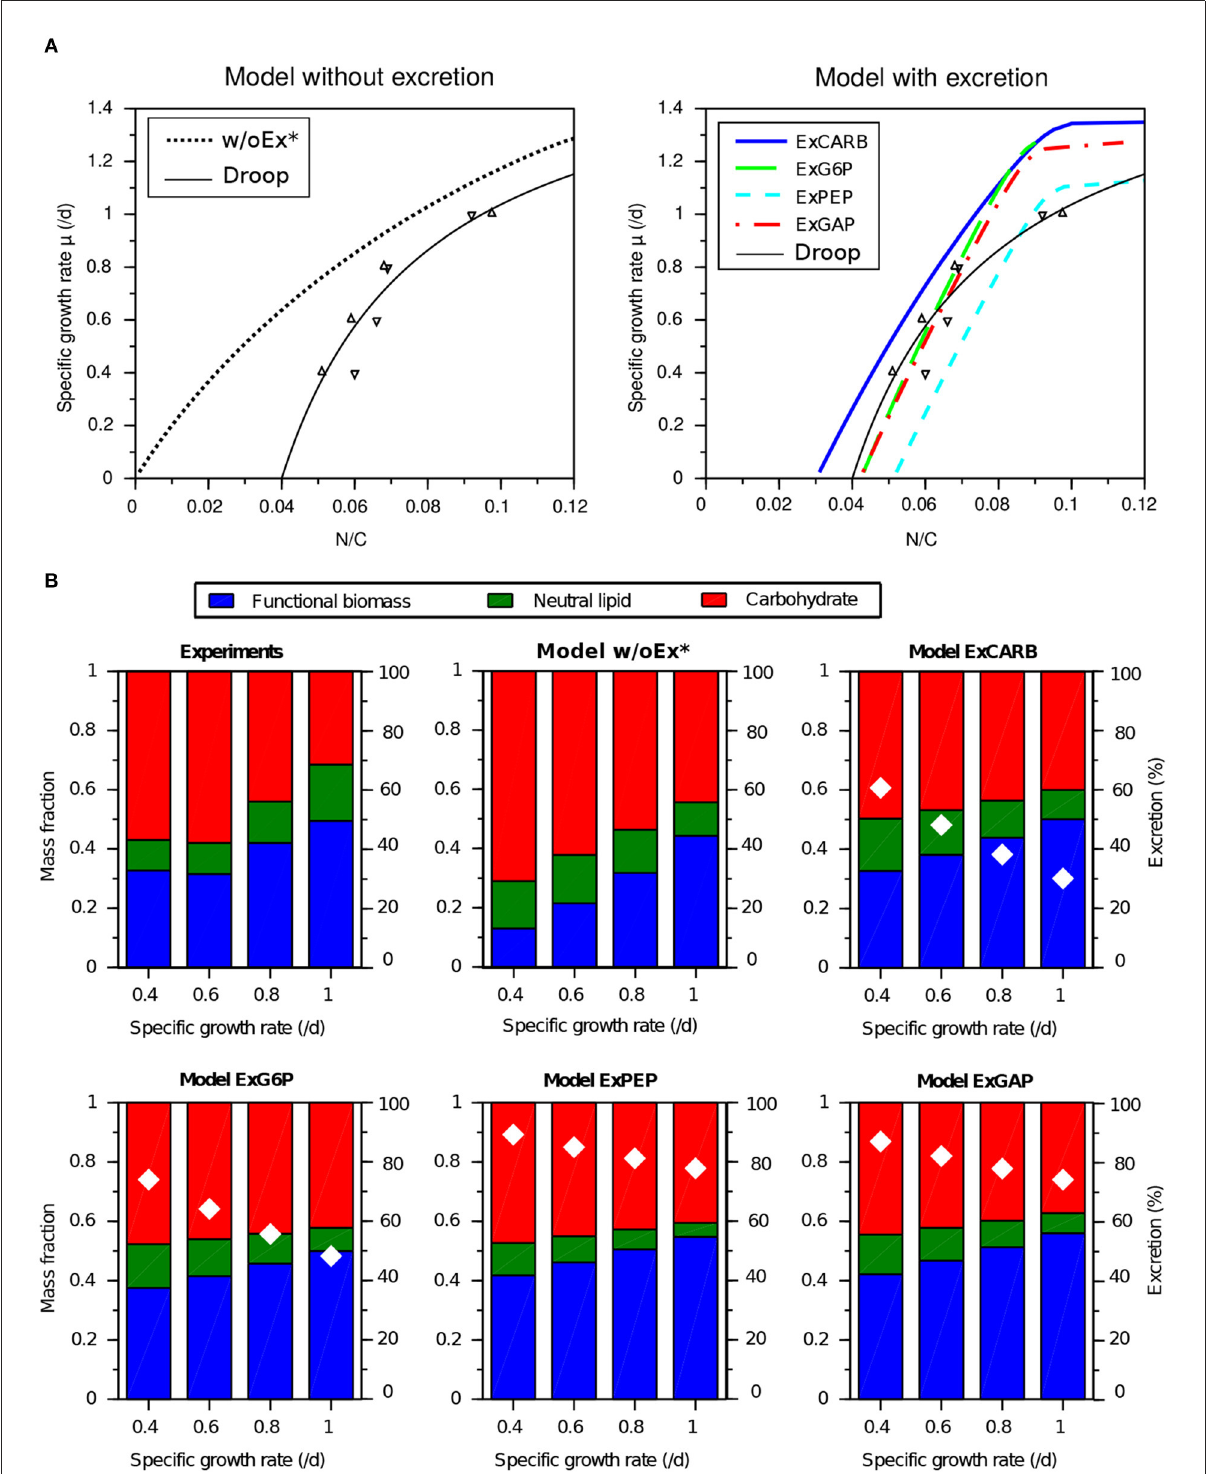
FIGURE7 Experimental observations and predictions of T. lutea growth and biochemical composition under nitrogen-limited balanced growth conditions (with constant light). Experimental data of different nitrogen-limited equilibria in chemostat (Lacour et al., 2012b) are used for model validation. (A) Specific growth rate as a function of the nitrogen quota. (B) Biochemical composition (color bars) and percentage of excreted carbon over total carbon fixed (white diamonds) as a function of the specific growth